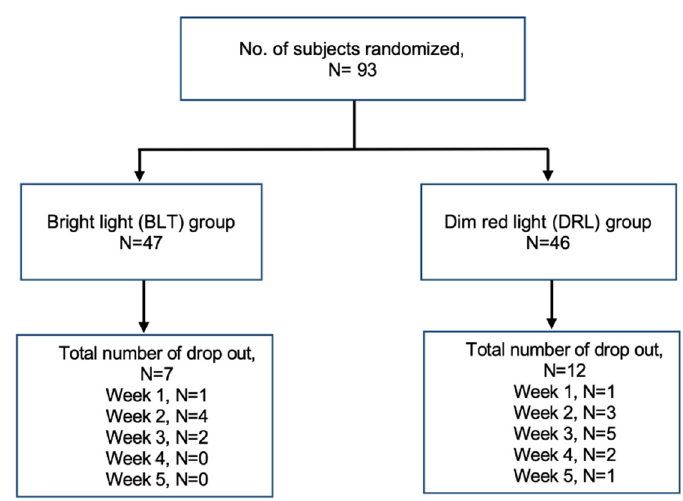
Figure 1. Subject flow diagram. Table 1. Baseline demographics and clinical characteristics of the Dropout group versus the Com- pleter group (means ± standard deviations).